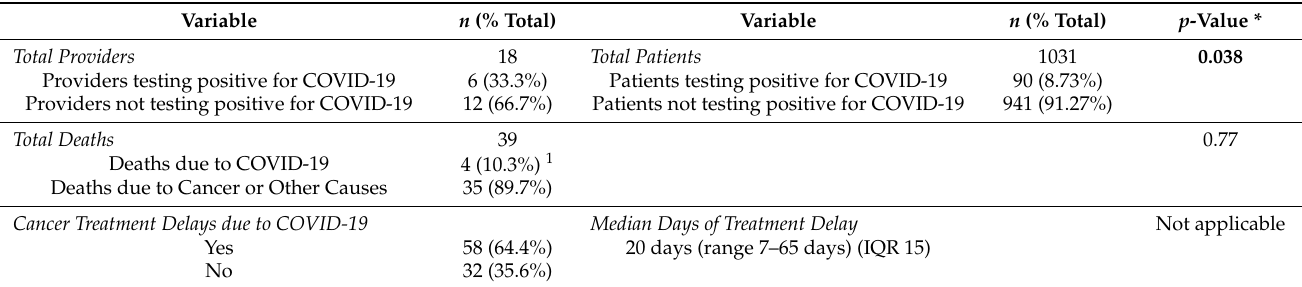
Table 1. COVID-19 Positivity and Key Outcomes among Hematology/Oncology Patients and Providers during the Initial Omicron